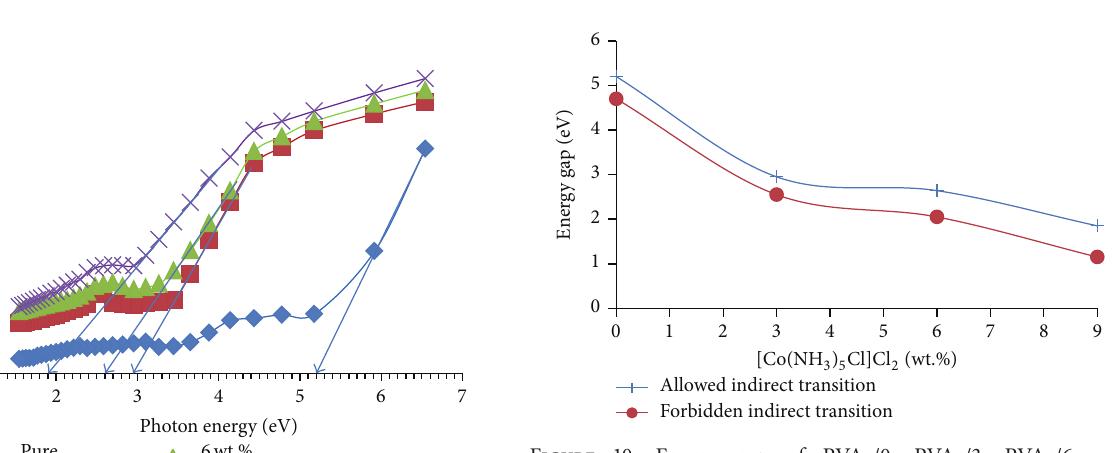
Figure 10: Energy gap of PVAc/0, PVAc/3, PVAc/6, and PVAc/9 wt.% of [Co(NH 3 ) 5 Cl]Cl 2 composites versus the concentra- tion of [Co(NH 3 ) 5 Cl]Cl 2 .